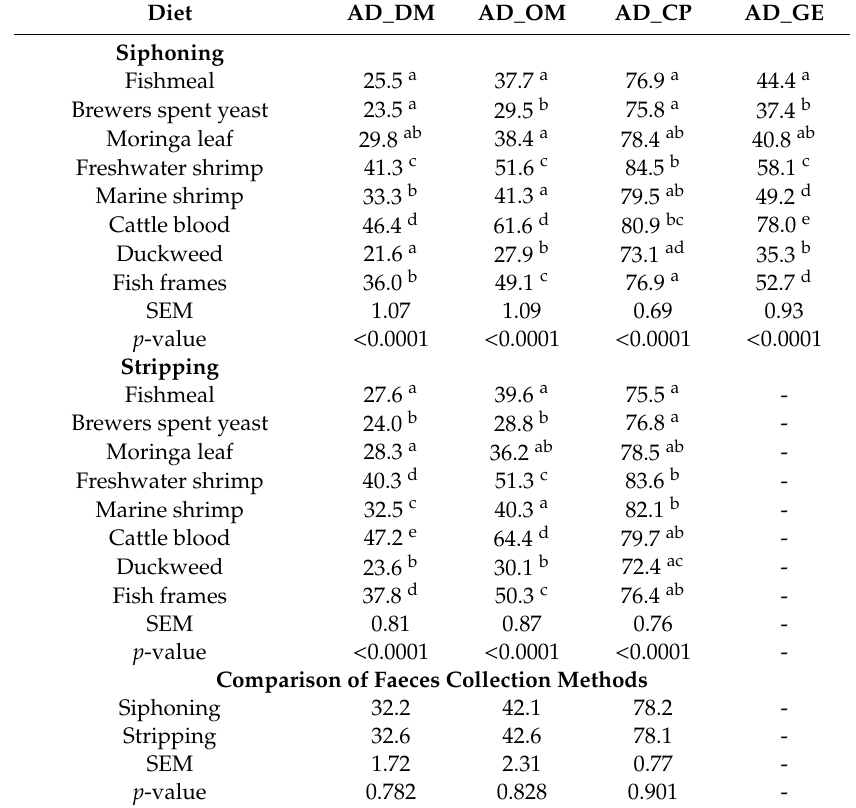
Table 3. Apparent digestibility (AD, %) of dry matter (DM), organic matter (OM), crude protein (CP) and gross energy (GE) in the reference diet (FMD) and test diets in Nile tilapia juveniles, determined on faeces collected by siphoning or stripping.